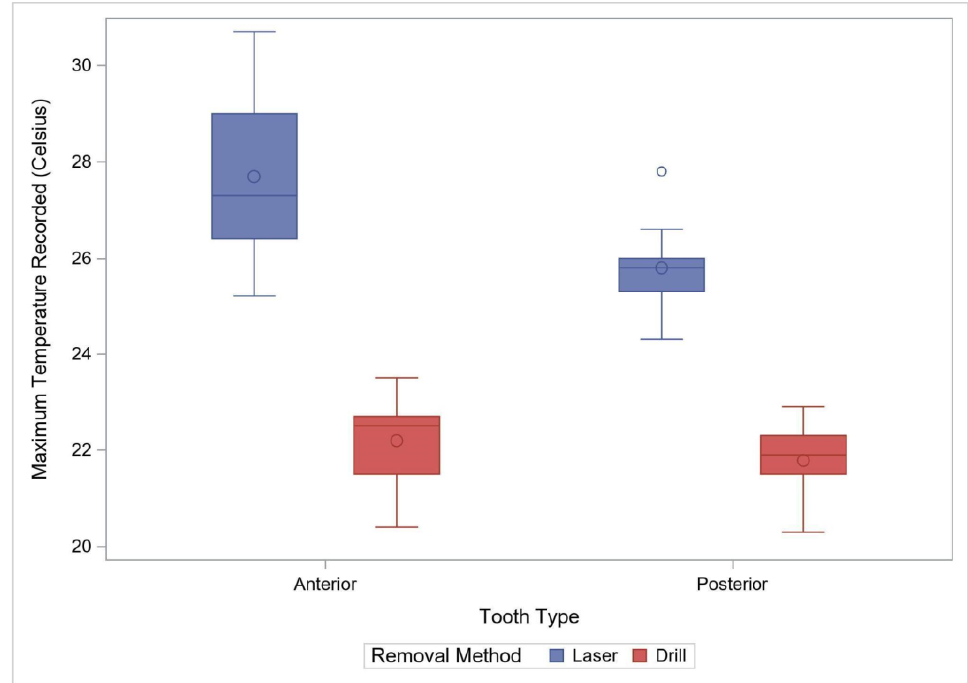
Figure 3. Comparison of Maximum Observed Temperature by Method for Anterior Primary and Posterior Permanent Teeth. The box plots demonstrate 95% confidence interval with “o” within the box plot representing a mean value, and “o” outside the box plot representing an outlier.